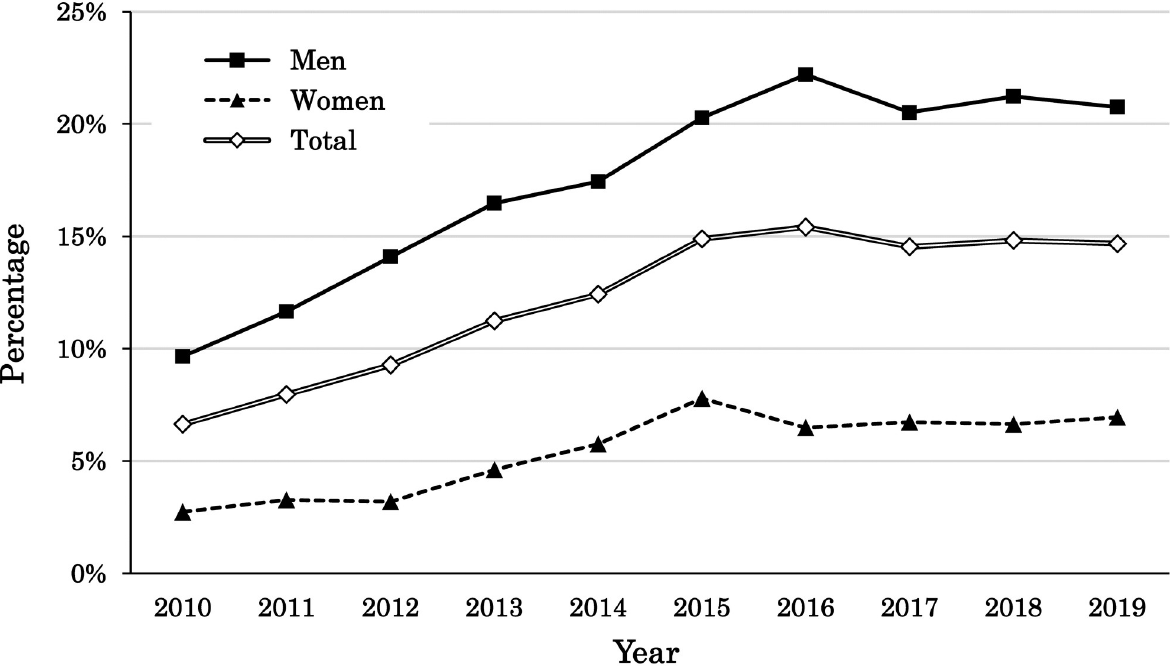
Fig 2. Changes in the prevalence of reflux esophagitis (men, women, and total) from 2010 to 2019 in Japan.